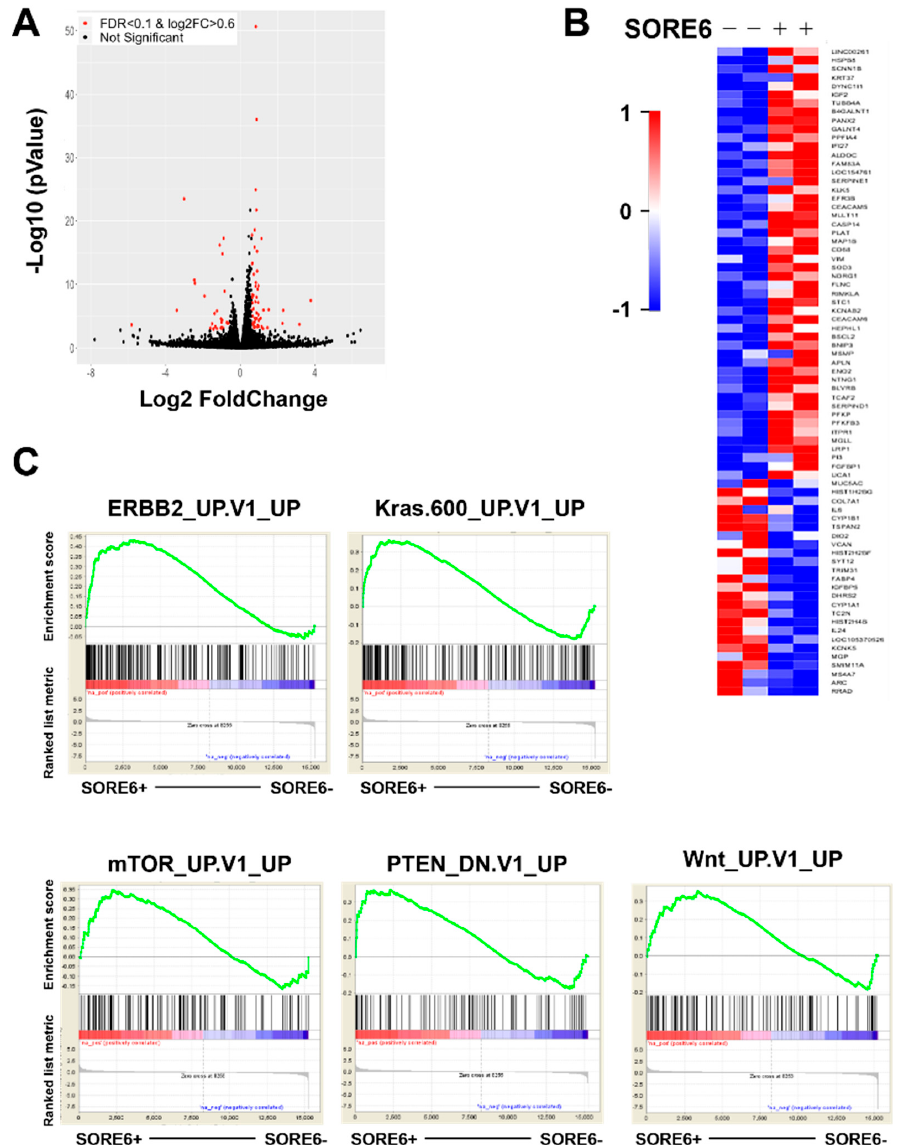
Figure 4. The transcriptome analysis of the altered gene expression in SORE6 + cells. ( A , B ) A volcano plot ( A ) and heatmap ( B ) show the genes differentially expressed between SORE6 + and SORE6 − PC3 cells, with a log 2 fold change ≥ 0.6 (linear 1.5-fold change) and FDR < 0.1. The differentially expressed genes are highlighted in red in the volcano plot. ( C ) The signaling pathways significantly enriched in SORE6 + cells were analyzed by GSEA, with adjusted p < 0.05 and FDR < 0.1.